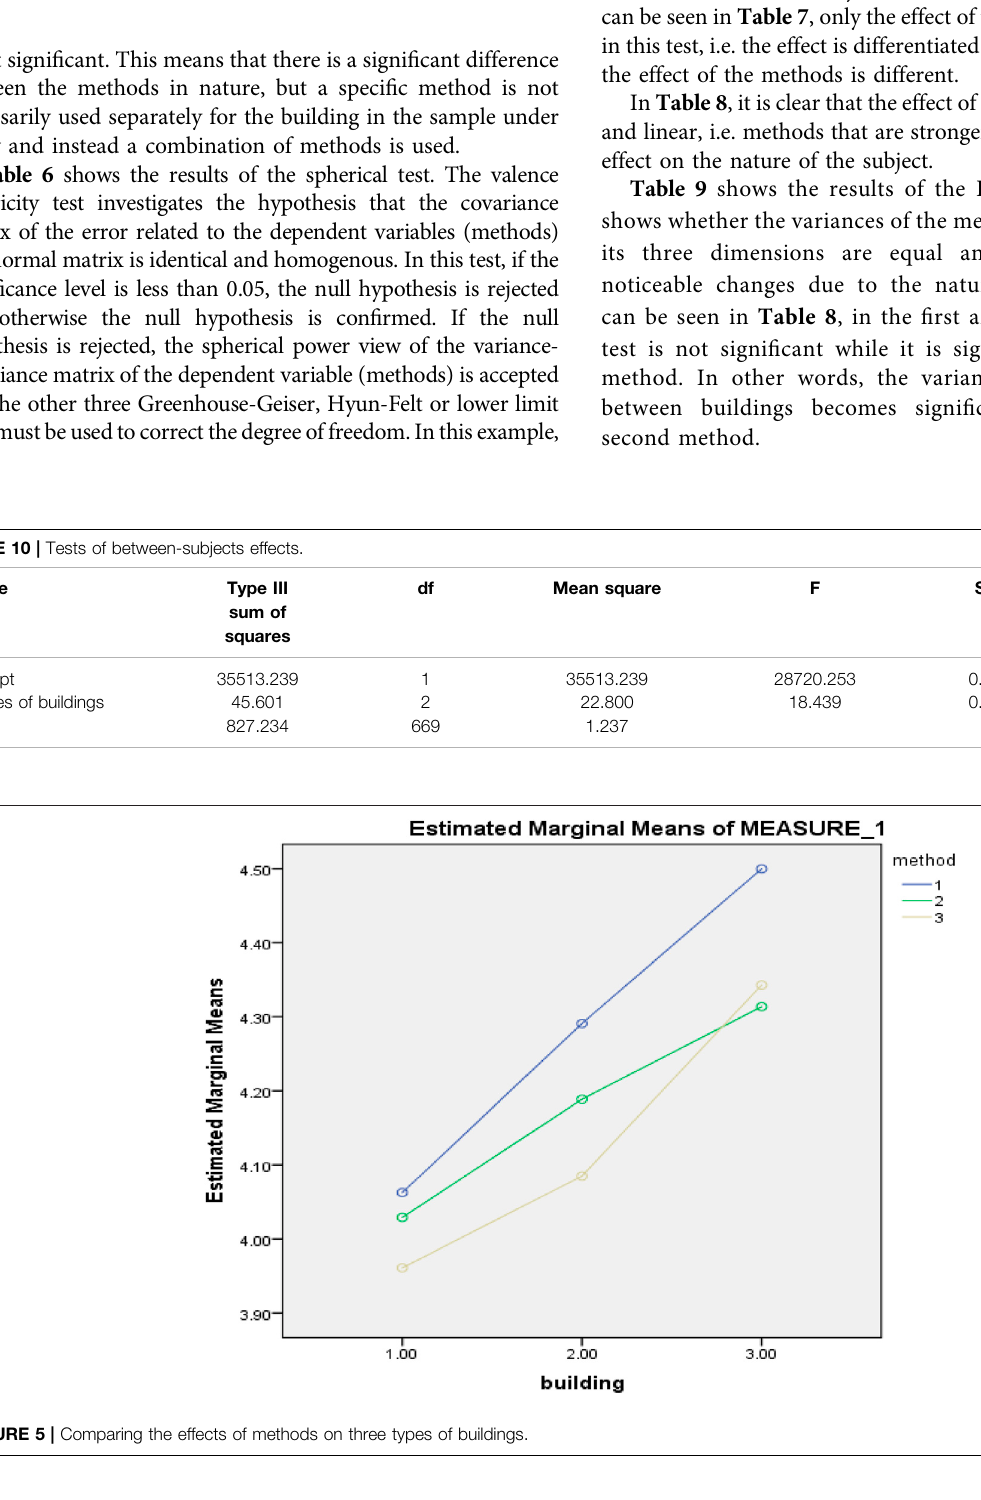
Frontiers in Built Environment |